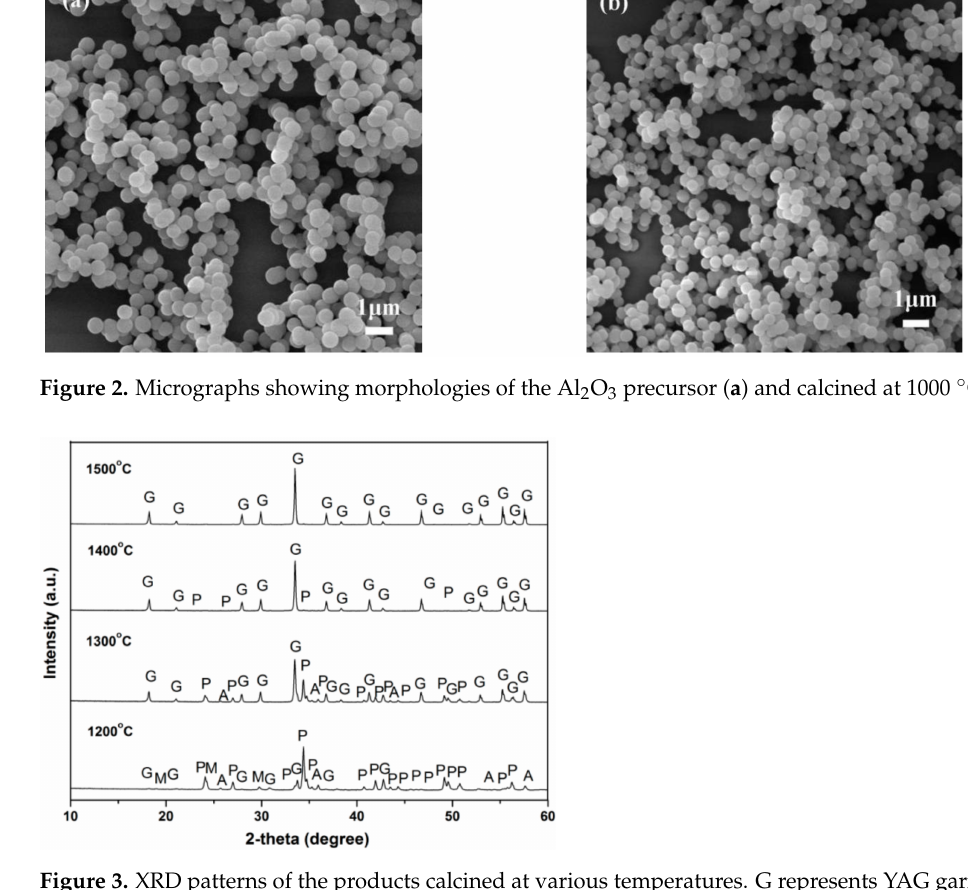
Figure 3. XRD patterns of the products calcined at various temperatures. G represents YAG garnet, P represents YAP phase, M represents YAM phase, and A represents Al 2 O 3